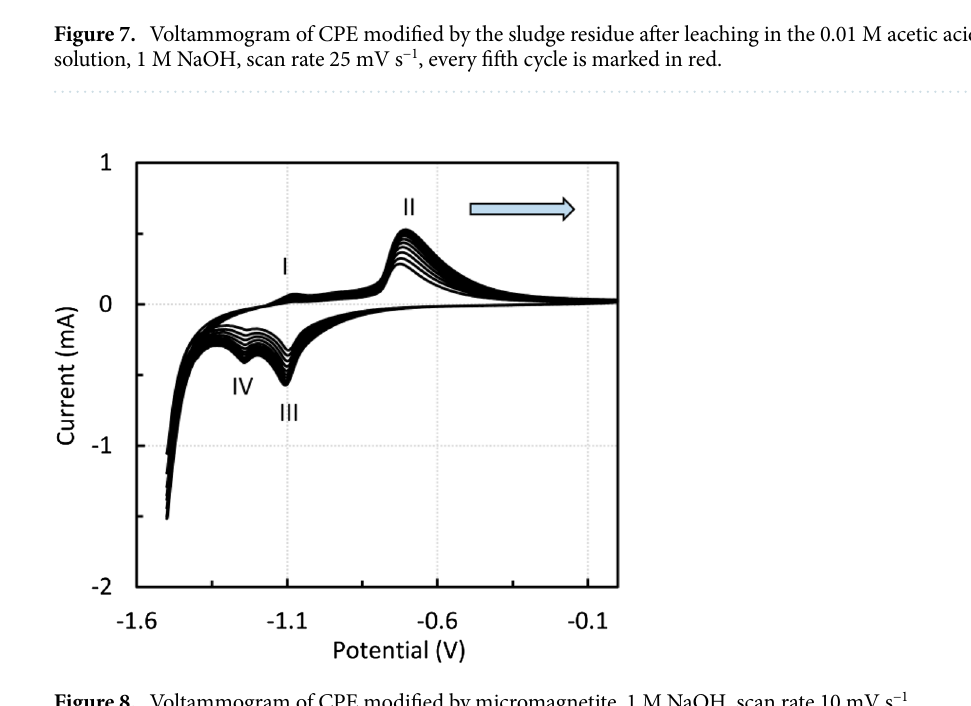
Figure 8. Voltammogram of CPE modified by micromagnetite, 1 M NaOH, scan rate 10 mV s −1